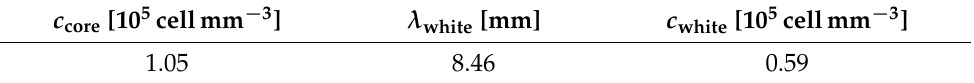
Table 2. Least-squares fitted values of the cell density model parameters in Equation (12) for the volume cell density data extrapolated using Equation (8) and plotted in Figure